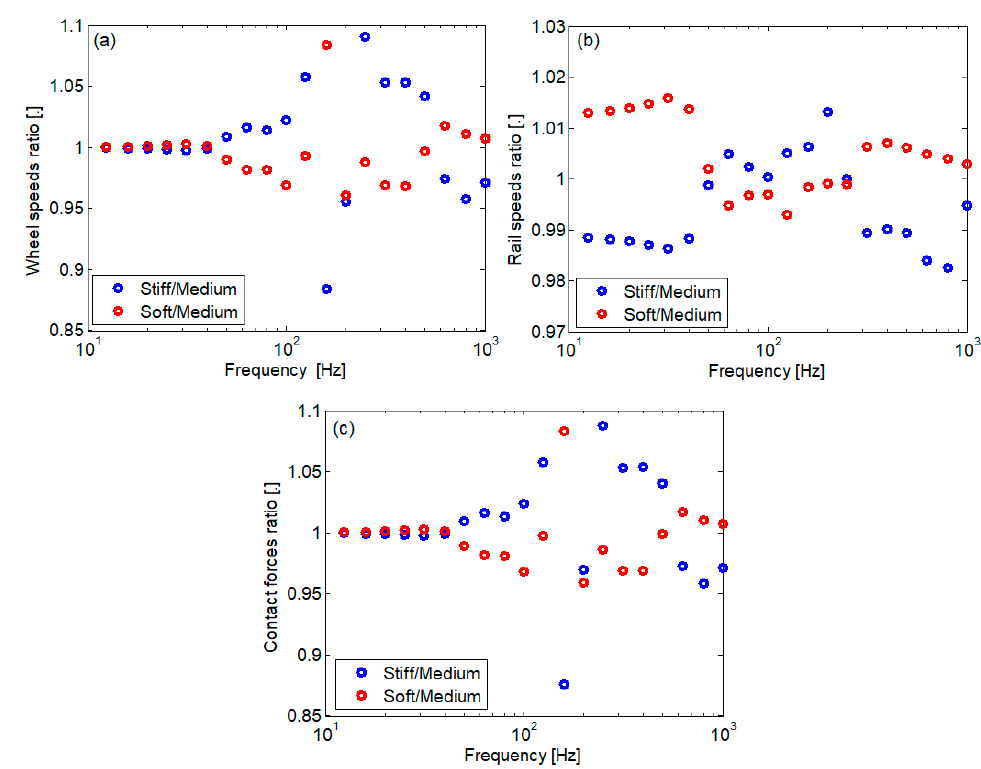
Figure 18. Spectral component ratios: ( a ) wheel speed; ( b ) rail speed; ( c ) contact force; color code as in Figure 15.